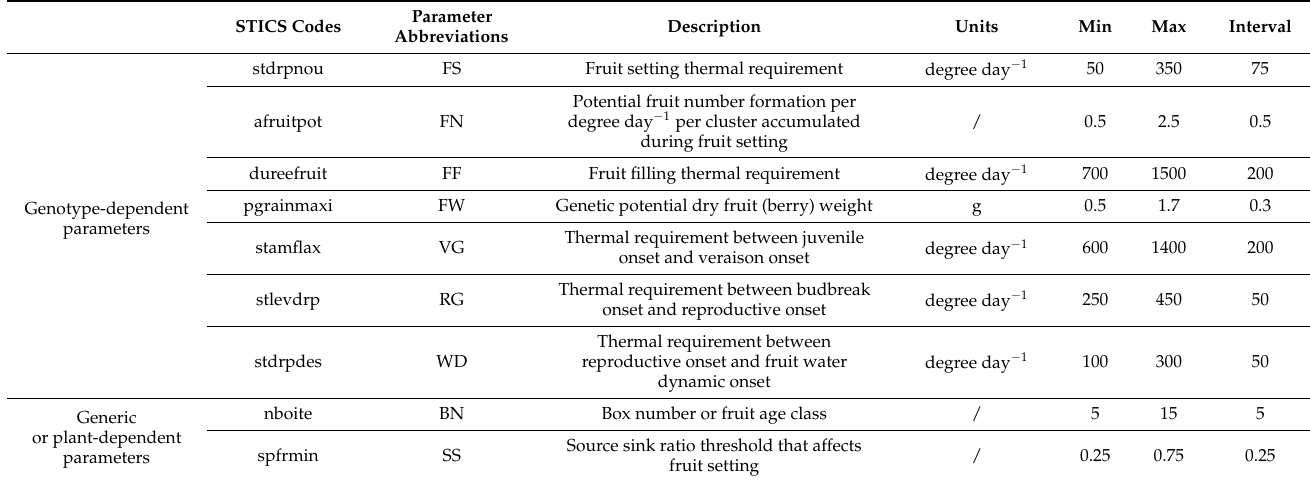
Table 2. List of tested STICS model parameters (description and value range) for calibration. Each genotype-dependent parameter was tested with five different values while the two generic (plant-specific) parameters were tested with three different values. In total, there are 703,125 parameter combinations (684,375 effective combinations) involved in the model